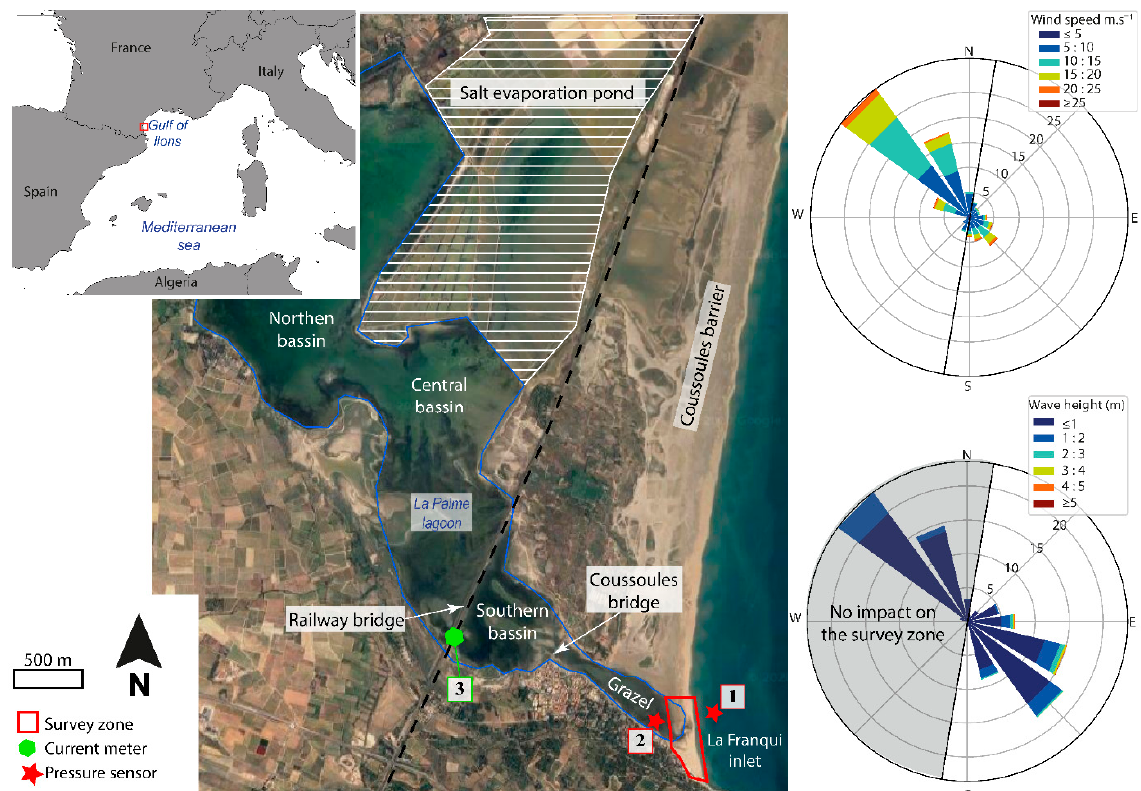
Figure 1. Location of the Coussoules barrier La Palme lagoon and Le Grau de La Franqui (42°55’56.12 ″ N; 3° 2’23.54 ″ E) with instrument positions and main forcings.